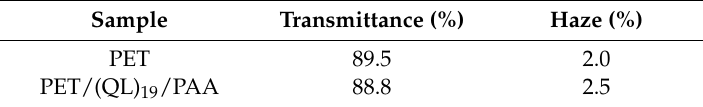
Figure 15. Photographs of ( a ) bare PET film and ( b ) PET-(QL) 19 composite film in front of a printing paper. Table 2. Optical properties of PET and PET-(QL) 19 films.